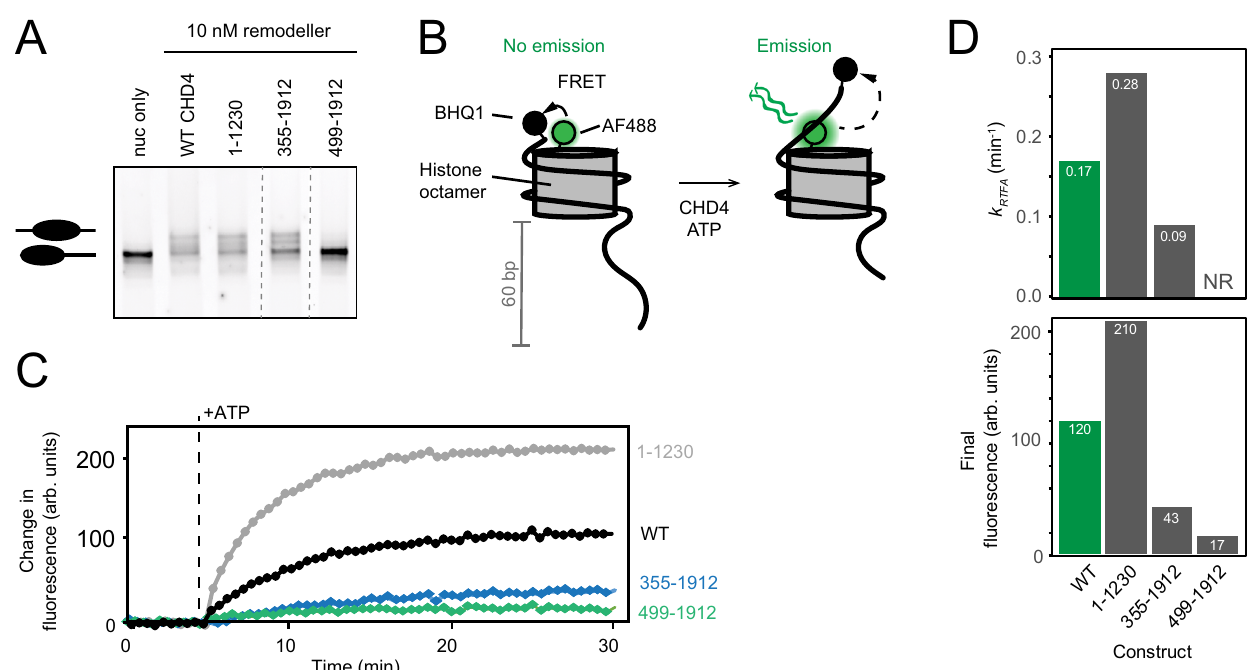
Fig. 2 | Gel-based and real-time fl uorescence assays (RTFA) for CHD4-driven nucleosome sliding. A Gel based nucleosome sliding assay conducted on WT CHD4 and a range of truncations. In each reaction, a 0w60 nucleosome (60 nM) is treated with 10nM CHD4 and 1mM ATP, which induces centring of the histone octamer (creating a 30w30 conformation). The two forms of the nucleosome can beresolvedonapolyacrylamidegel,asindicated.Dashedlinesindicatewherelanes from the same gel have been cut and repositioned. This experiment has been repeatedthreetimes;allshowedsimilarresults. B Setupforreal-time fl uorescence assay to measure nucleosome sliding. A 0w60 nucleosome is assembled in which H2AislabelledwithAF488( green )andtheshortendoftheDNAislabelledwiththe BHQ1 fl uorescencequencher.No fl uorescenceisobservedinthisstate.Additionof CHD4 ad ATP results in an increase in fl uorescence as histone octamer is